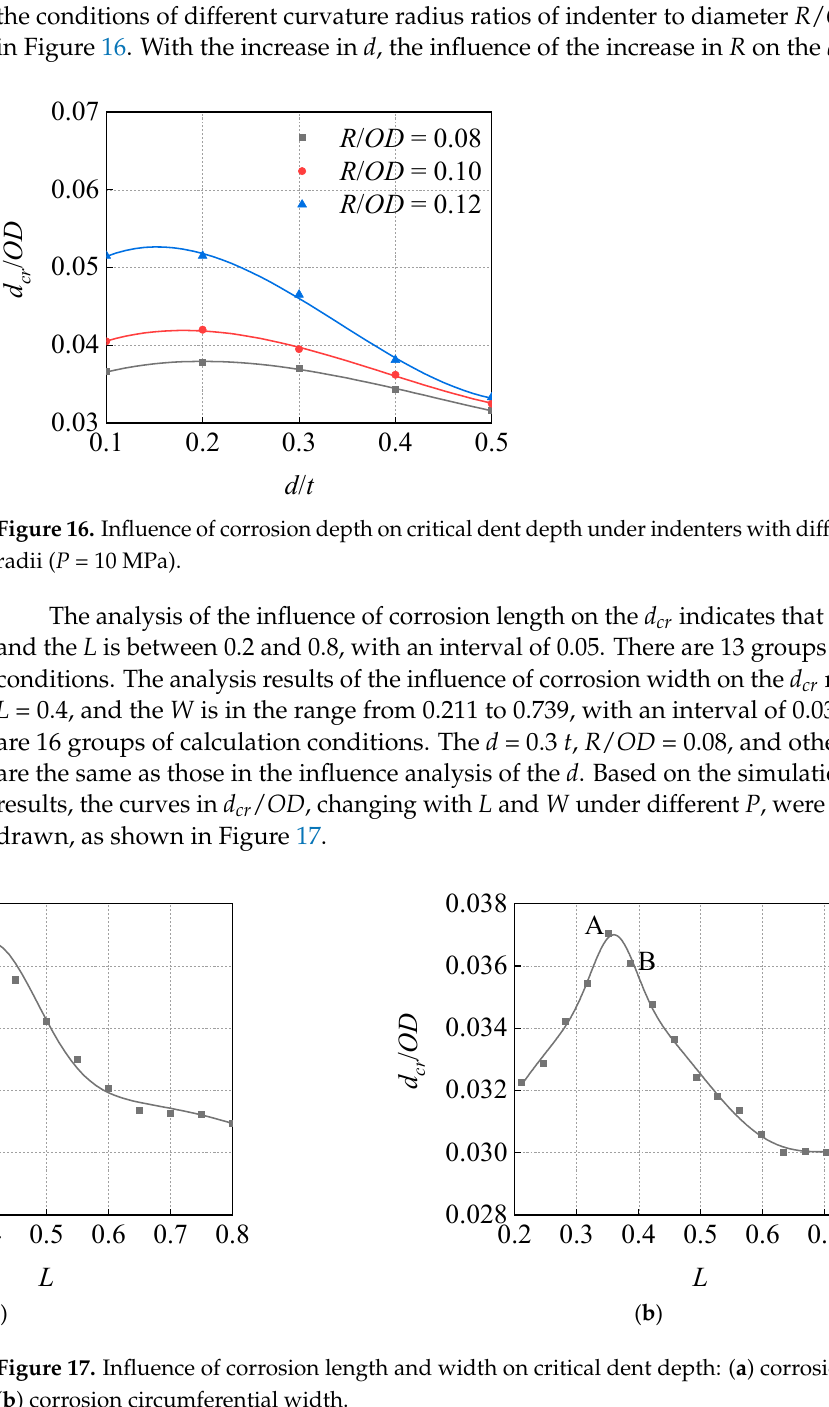
tions are more dangerous. For small-size corrosion, when the length and width are close, both the length and width edges of the corrosion can contact the indenter, whose R = 65.04 mm at the initial contact stage, in a very short, semi-spherical indenter displacement. Ow- ing to the special shell surface structure of the pipeline, when the annular width of the corrosion is slightly shorter than the axial length, the semi-spherical indenter can just con- tact the length and width edge of the corrosion at the same time, and the structure can bear the maximum external load of the indenter. Furthermore, Figure 17b illustrates that